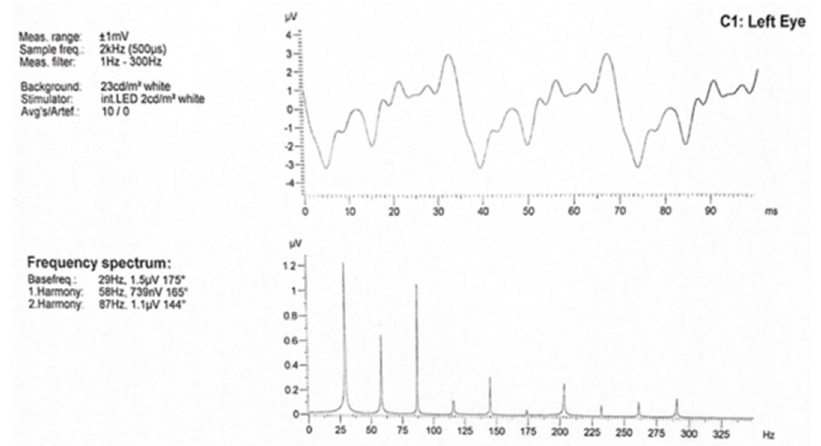
Figure 4. Electroretinographic examination.